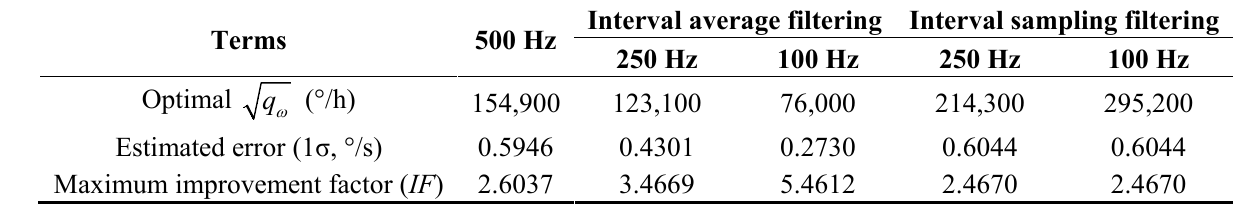
Table 1. Simulation results of a virtual gyroscope with different filtering